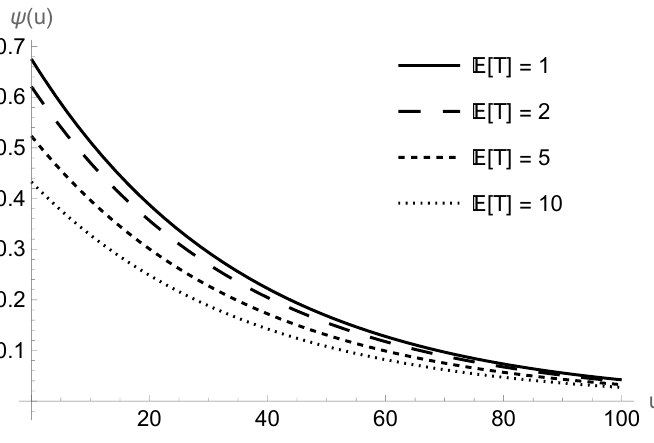
Figure 2. Modified Parisian ruin probability ψ ( u ) for E [ T ] = 1,2,5,10 using n =